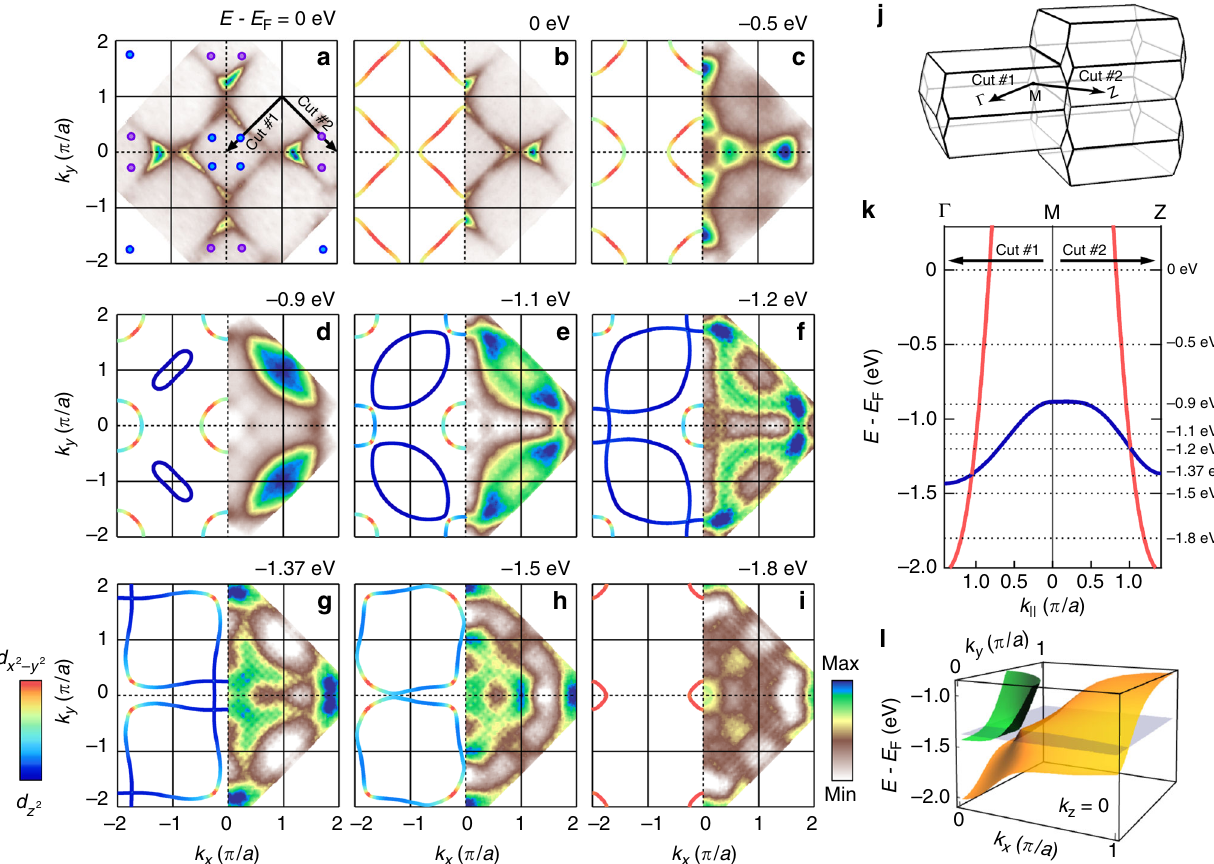
Fig. 4 Iso-energetic mapping of the type-II Dirac fermions. a Fermi surface map of La 1.77 Sr 0.23 CuO 4 (no symmetrisation applied). Blue and purple circles, respectively, indicate the momentum positions of the equivalent Dirac points. b – i Constant-energy surfaces at binding energies as indicated. Each panel shows the experimental map (right) and the tight-binding surface colour-coded according to the orbital character (left). The maps have been symmetrised assuming four-fold rotational symmetry and mirror symmetry with respect to the diagonal direction. j Sketch of the three-dimensional Brillouin zone. k Tight-binding band dispersion along the diagonal cuts indicated in panels a and j . Dotted lines indicate the selected constant-energy maps shown in b – i . l Schematic plot of the present type-II Dirac cone in energy — k x − k y space at k z = 0